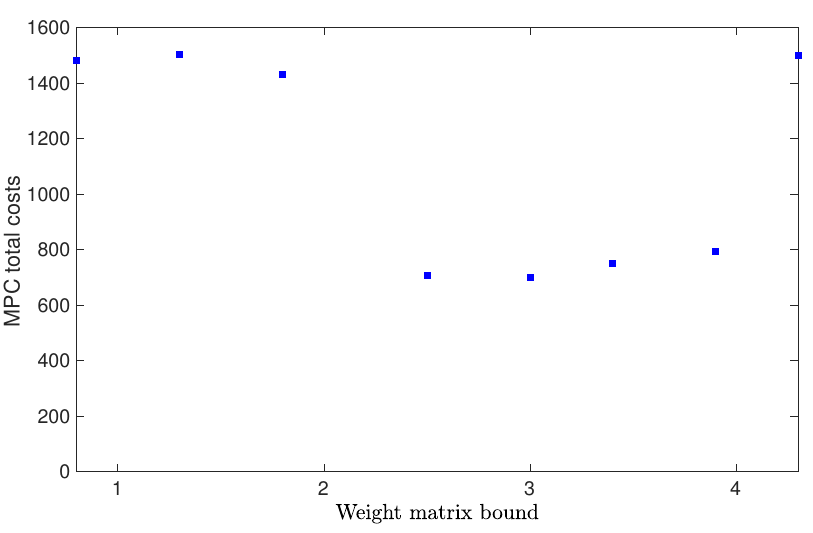
Figure 20. MPC total costs vs. weight matrix bound.